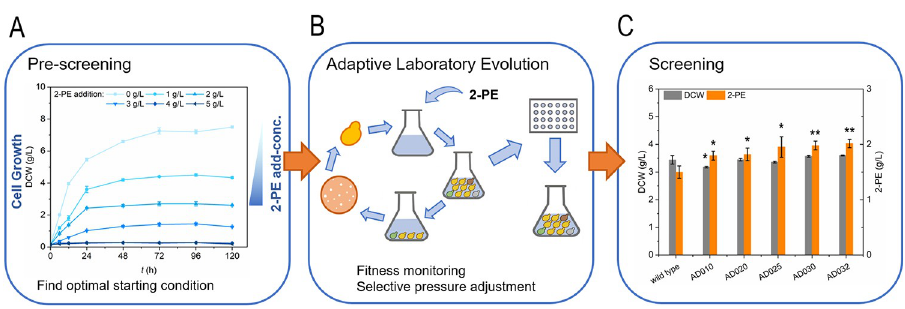
Fig 2. Overview of the experimental procedures used to obtain 2-PE tolerant yeast strain. (A) Cell growth of the control strain WT-A in YEPD medium added with different concentration of 2-PE addition. (B) Schematic diagram of the adaptive laboratory evolution process of S . cerevisiae strain AD032. (C) Cell growth and 2-PE titer of ALE stains in YSM light medium. Data are presented as the averages of the results of three independent experiments. Error bars show standard deviations. Error bars show standard deviations. Statistical analysis was performed by using Student’s t- test (one-tailed; two-sample unequal variance; � p < 0.05, �� p < 0.01, ��� p < 0.001).